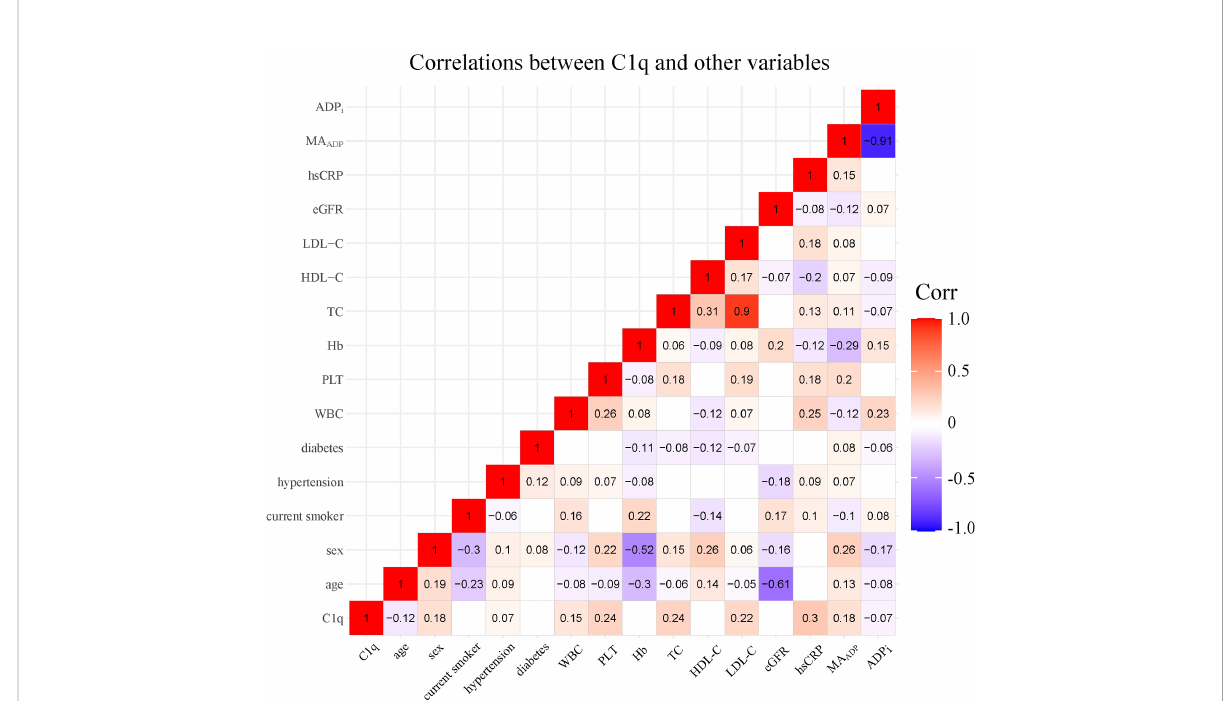
FIGURE 2 Correlations between C1q and covariates of interest. The number and color in each box represented correlation coef fi cient for two covariates corresponding to the box, of which blank indicated non-statistically signi fi cant association. PLT, platelet count; Hb, hemoglobin; WBC, white blood cell count; TC, total cholesterol; LDL-C, low density lipoprotein cholesterol; HDL-C, high density lipoprotein cholesterol; eGFR, estimated glomerular fi ltration rate; hs-CRP, high-sensitivity C-reactive protein; MA ADP , Maximum amplitude of ADP-induced clot strength; ADP i , ADP- induced platelet inhibition